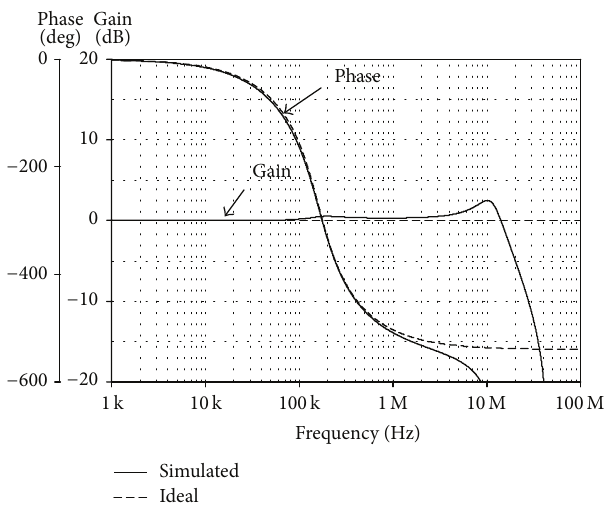
Figure 9: Simulated and ideal frequency responses of the realized third-order all-pass circuit in Figure 6(b).